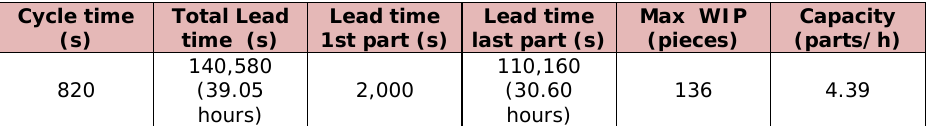
Table 3. “Key metrics for the initial production